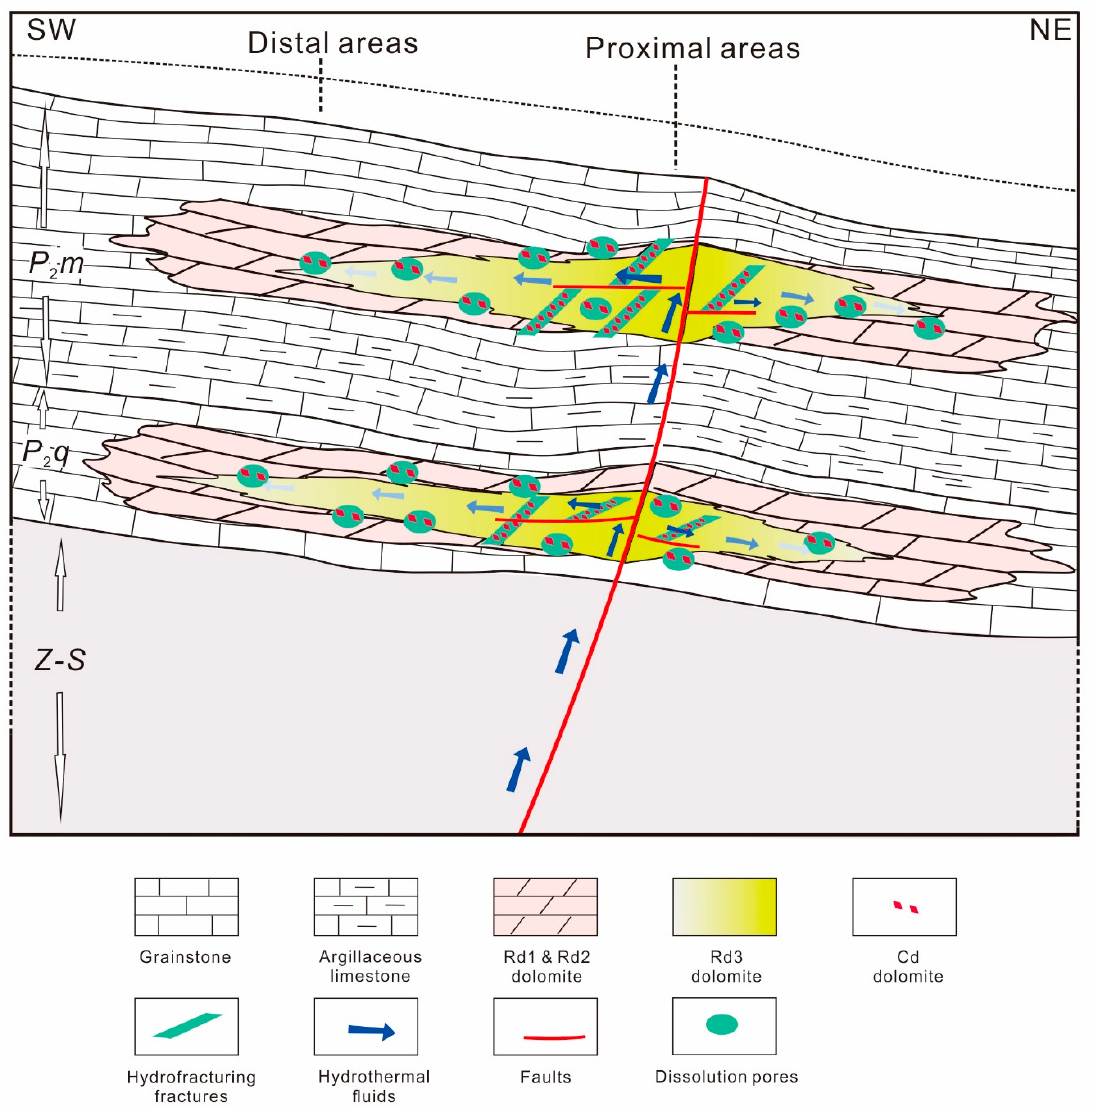
Figure 19. A model of multiple dolomitization events in the Middle Permian carbonates.